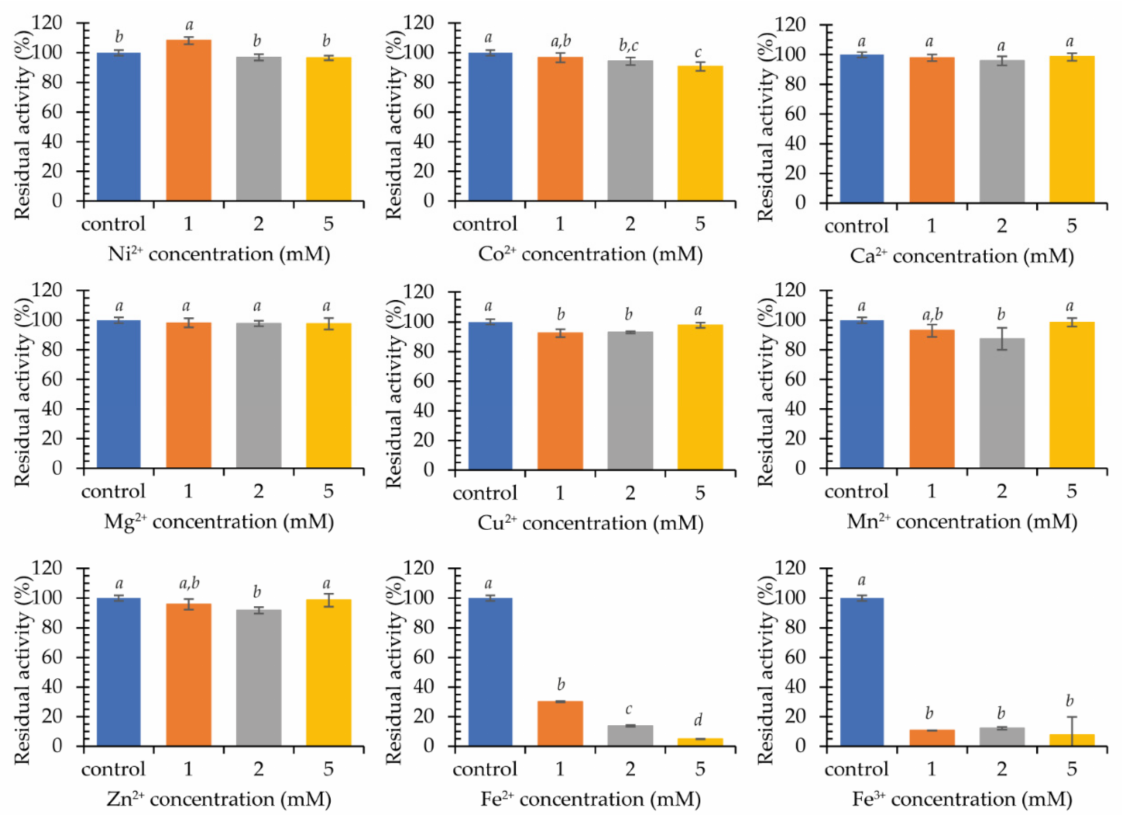
Figure 7. Stability of purified recombinant laccase KbLcc1 activity after 24 h of pre-incubation in the presence of various metal ions; the data presented as the means ± SD from at least three independent experiments; the means that are marked with different letters ( a – d ) are significantly different ( p <